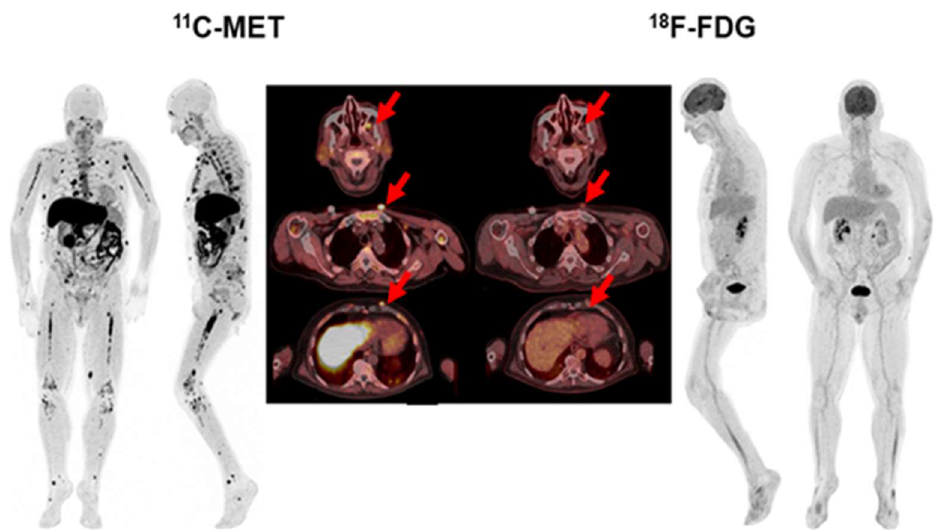
Figure 6. 68-year-old patient with Bence Jones Lambda MM ISS-2. While FDG PET/CT showed focal uptake in subcutaneous lesions located in the chest and pulmonary nodules in lower lungs (red arrows), MET PET/CT also revealed a greater number of lung lesions, as well as pleural, lymph nodes, frontal sinus infiltration, and extensive BM infiltration.